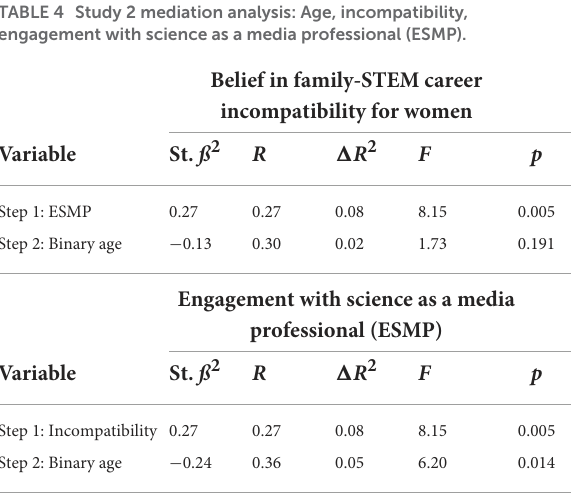
TABLE 4 Study 2 mediation analysis: Age, incompatibility, engagement with science as a media professional